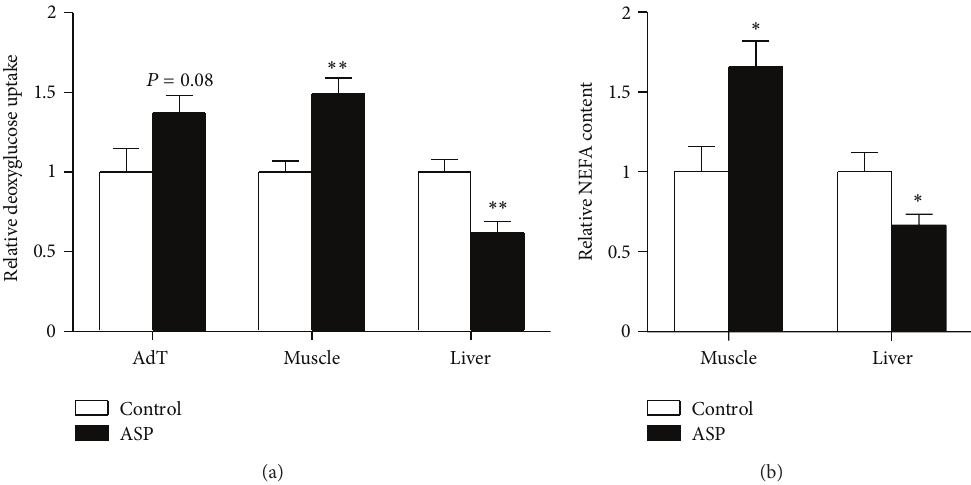
Figure 2: ASP affects substrate partitioning. Relative 3 H-deoxyglucose uptake in adipose tissue (AdT), liver and skeletal muscle is shown in (a). Relative nonesterified fatty acid content of liver, and skeletal muscle is shown in (b). Results are expressed as relative absorption or content compared with controls (vehicle) which are set as 1.0. Results are expressed as mean ± SEM where differences versus controls (vehicle) are expressed as ∗ 𝑃 < 0.05 and ∗∗ 𝑃 < 0.01 , with 𝑛 = 7-8 per group.